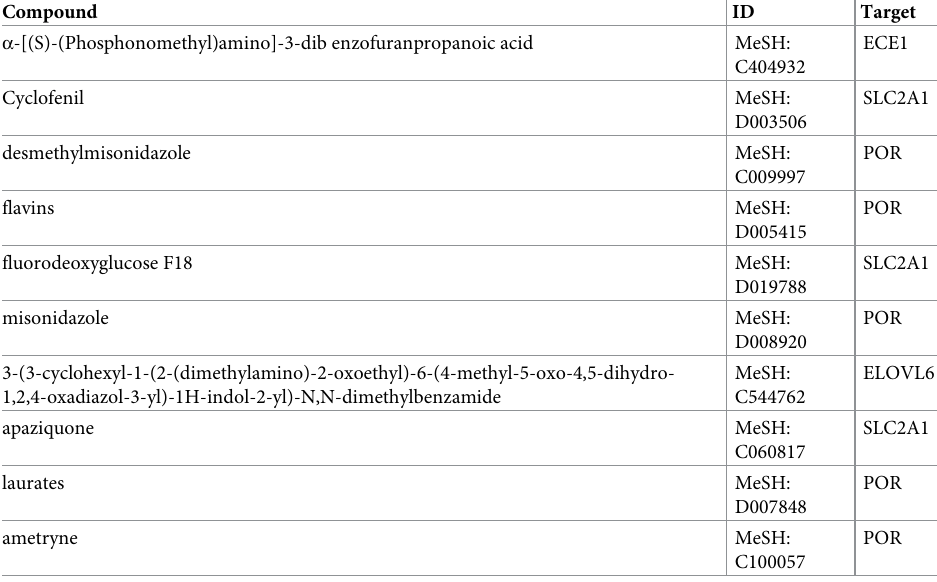
Table 2. The top ten compounds known to interact with any of the 45 genes found at the intersection of cross-spe- cies dietary restriction aging studies.